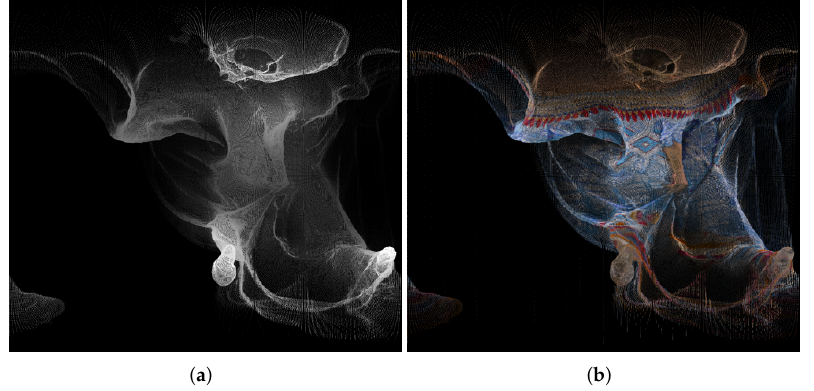
Figure 3. Panorama images created using point cloud “longdress_vox10_1060.ply” from the cylindri- cal projection, for the geometry ( a ) and texture ( b ).